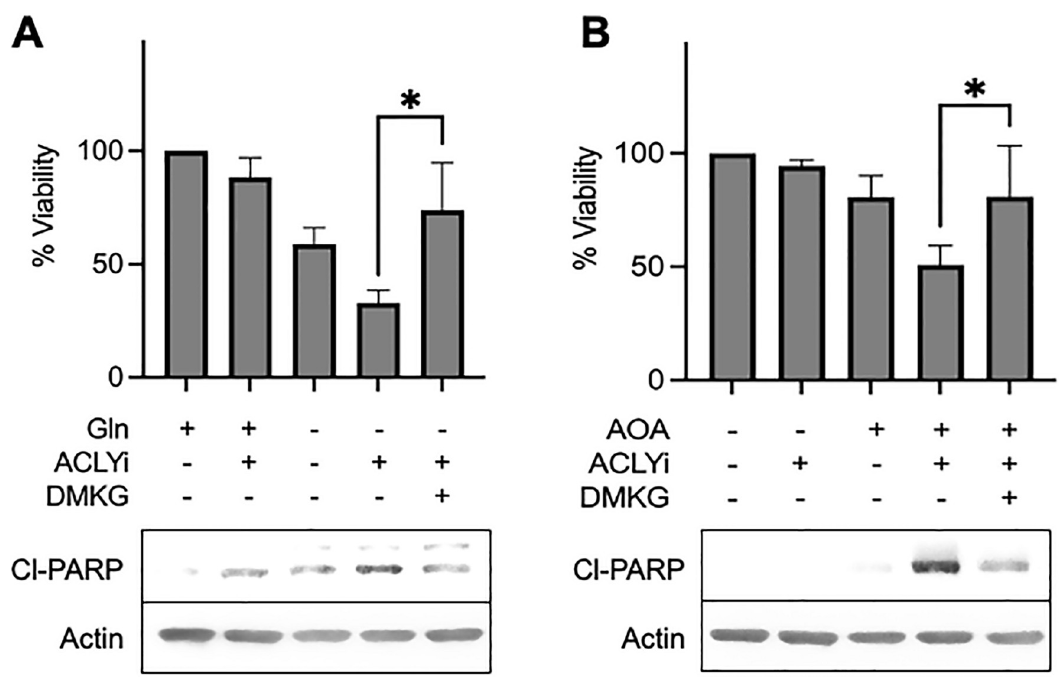
Fig 5. DMKG rescues cytotoxic effect of ACLY inhibition upon Gln deprivation or Gln utilization in KRas-driven cancer cells. ( A ) MDA-MB-231 cells were plated at 50% confluence in 96-well plates in complete medium (CM) containing 10% FBS. After 24 hr, cells were shifted to medium containing or lacking glutamine for 48 h. For the last 24 hr, cells were transferred into media containing SB-204990 (40 μ M) with or without DMKG. Plates were read after 24 hr in plate reader and analyzed for cytotoxicity via XTT assay. Lysates were collected and analyzed for protein expression via western blotting. (B ) MDA-MB-231 cells were plated as in A . After 24 hr, cells were shifted to medium containing or lacking AOA for 48 hr. For the last 24 hr, cells were transferred into media containing SB-204990 (40 μ M) with or without DMKG (4 mM). Plates were read after 24 hr in plate reader and analyzed for cytotoxicity via XTT assay. Lysates were collected and analyzed for protein expression via western blotting. All experiments were repeated two or more times. Error bars represent ± SEM. Unpaired Student’s t-test was performed for statistical analysis. The Western blots shown are representative of experiments repeated at least two times.